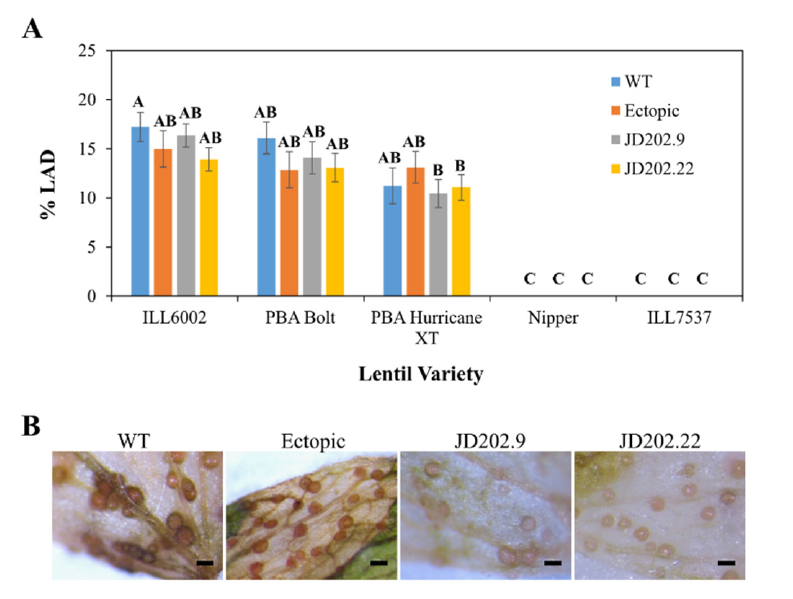
Figure 5. Pathogenicity test of Al Kewell and transformants on di ff erent lentil varieties. ( A ) Leaf lesions of the four nodes that were spray inoculated (% leaf area damage) are reported as mean values from nine plants of each variety and error bars reported as standard error of the mean. Bars not connected by same letter are significantly di ff erent (Tukey HSD test, p < 0.0001). ( B ) Representative photo from three replicates of pycnidia on susceptible lentil accession ILL6002 at 14 DPI. Photos were taken using SMZ-800 stereomicroscope with a DS-Fi1C Digital camera (Nikon Instruments, Melville, NY, USA). Scale bars are 200